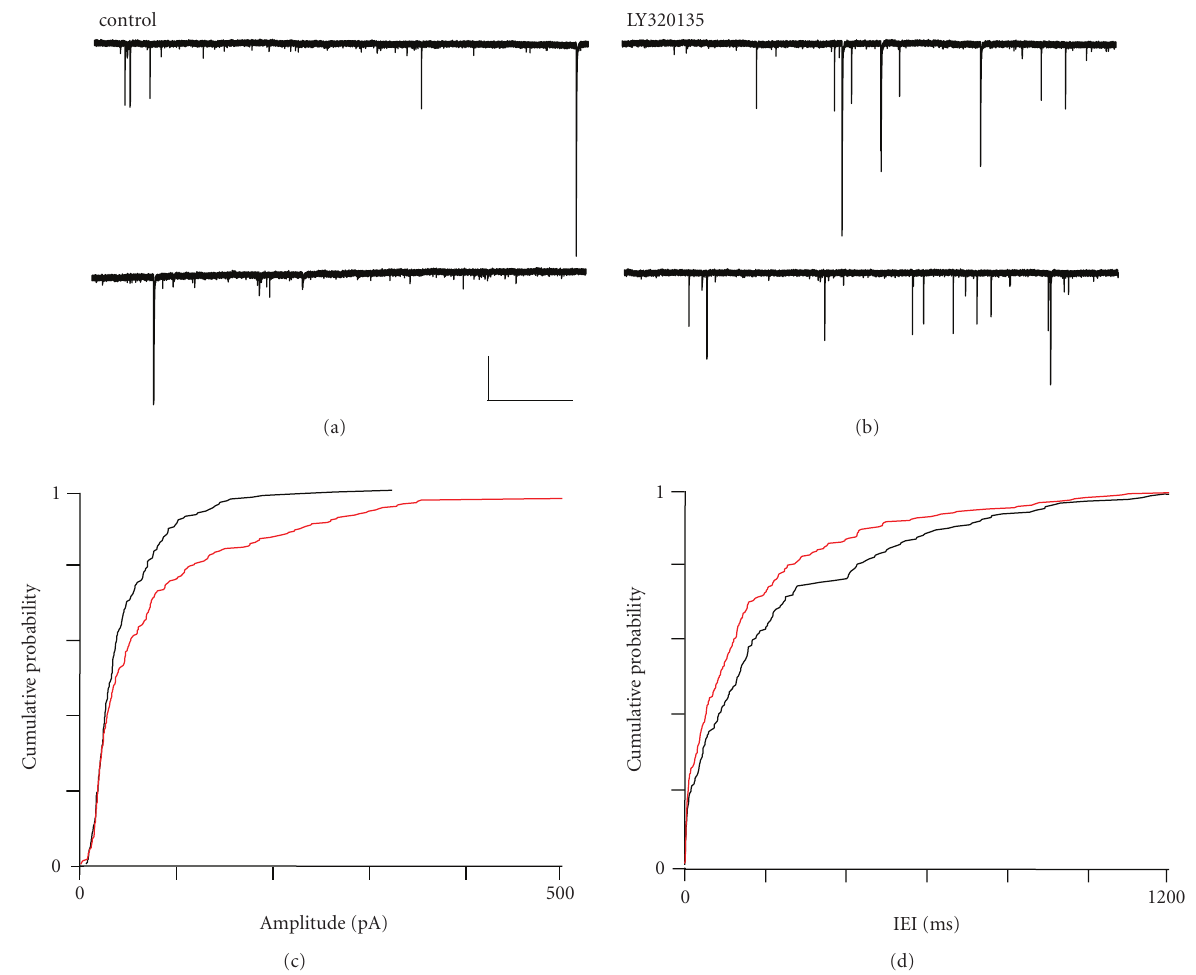
Figure 9: The e ff ects of LY320135 on sIPSCs in mEC layer V. (a) Recording from a layer V neurone under control conditions and (b) in the presence of LY320135 (500 nM). (c) Cumulative probability plot for sIPSC amplitude under control (black) and LY320135 (red) conditions. (d) Cumulative probability plot for sIPSC IEI under control (black) and LY320135 (red) conditions. Scale bars 2000 milliseconds ×